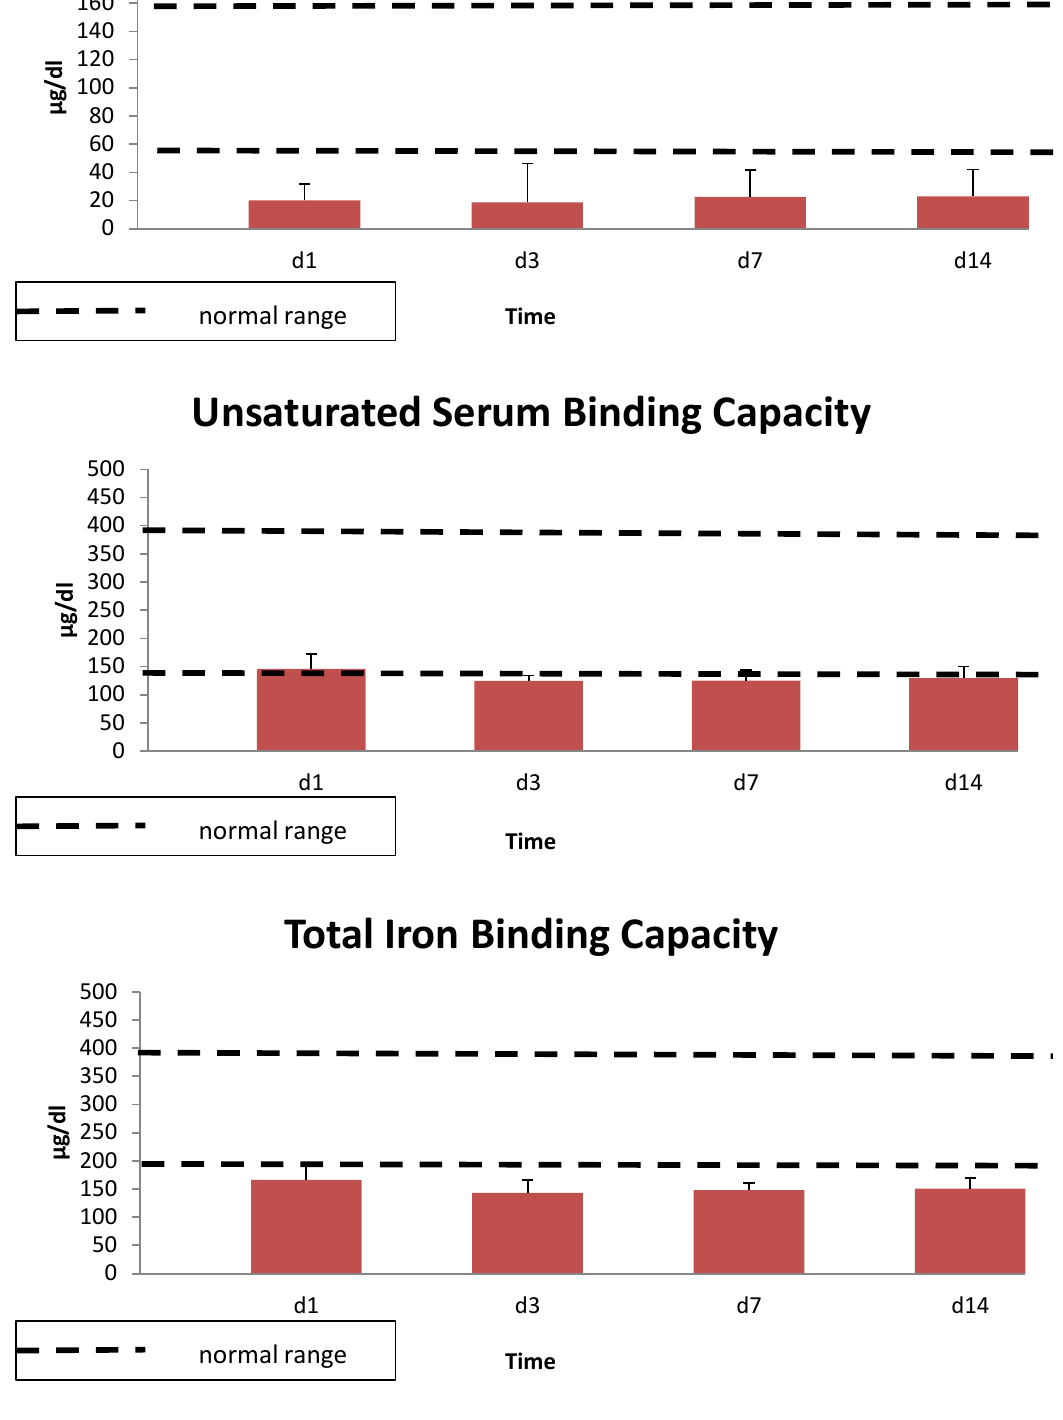
Figure 1. Serum iron (Fe +2 ), unsaturated iron binding capacity and total iron binding capacity over 14 days in 10 thermally injured patients. Data expressed as mean ± SE. Dotted lines denote the upper and lower normal